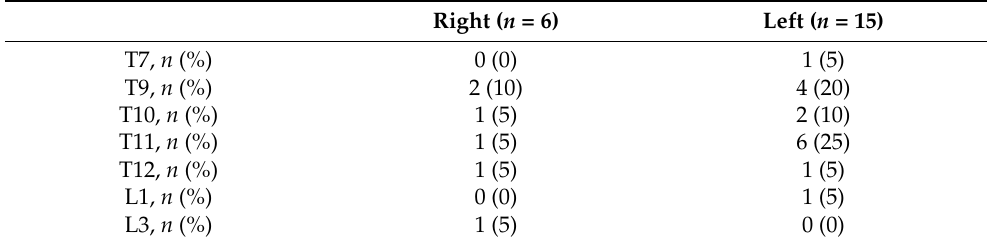
Table 3. Distribution of the side and the level of the origin of the Adamkiewicz artery (AA) ( n = 21).